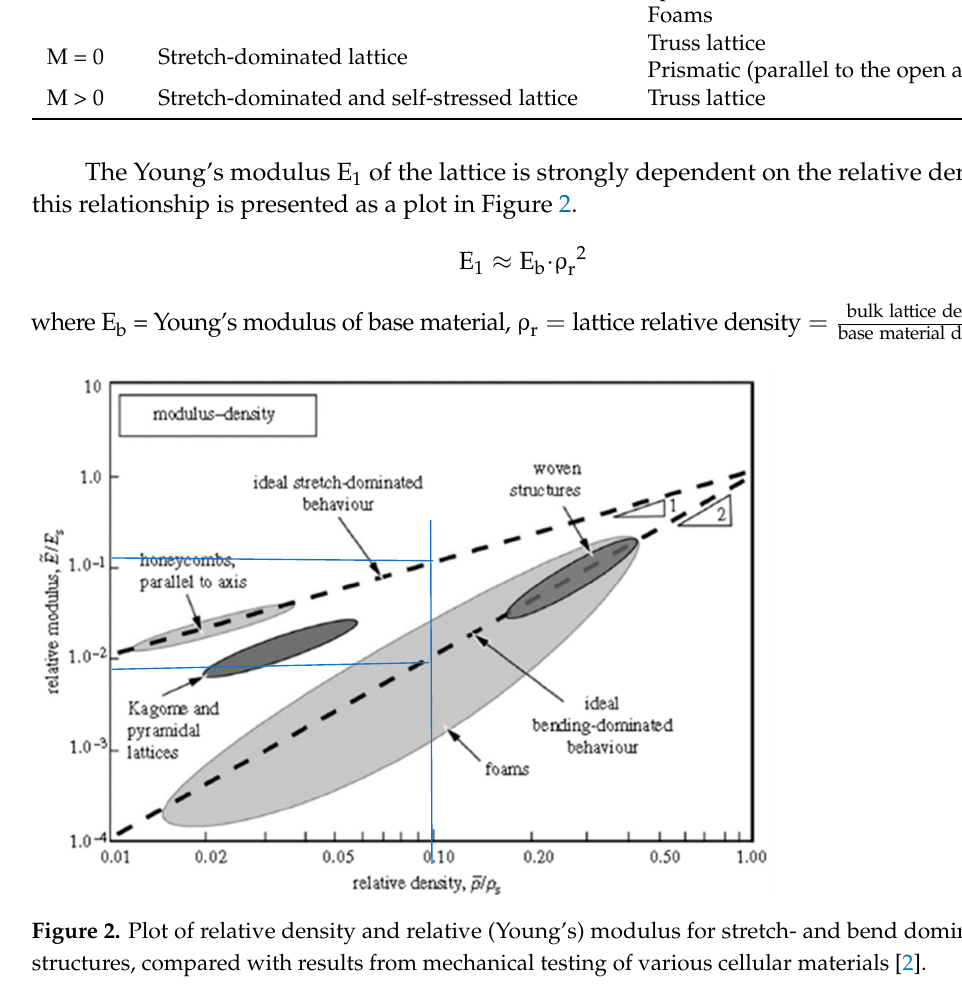
Truss lattice Prismatic (perpendicular to the open axis) Foams Truss lattice Prismatic (parallel to the open axis)